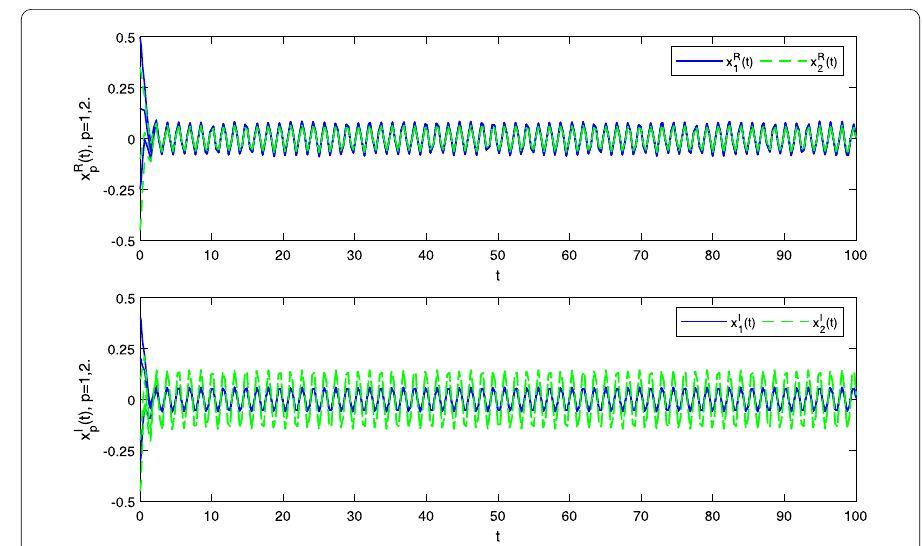
Figure 1 Curves of x R p ( t ) = ( x R 1 ( t ), x R 2 ( t )) T and x I p ( t ) = ( x I 1 ( t ), x I 2 ( t )) T of system (12) with the initial